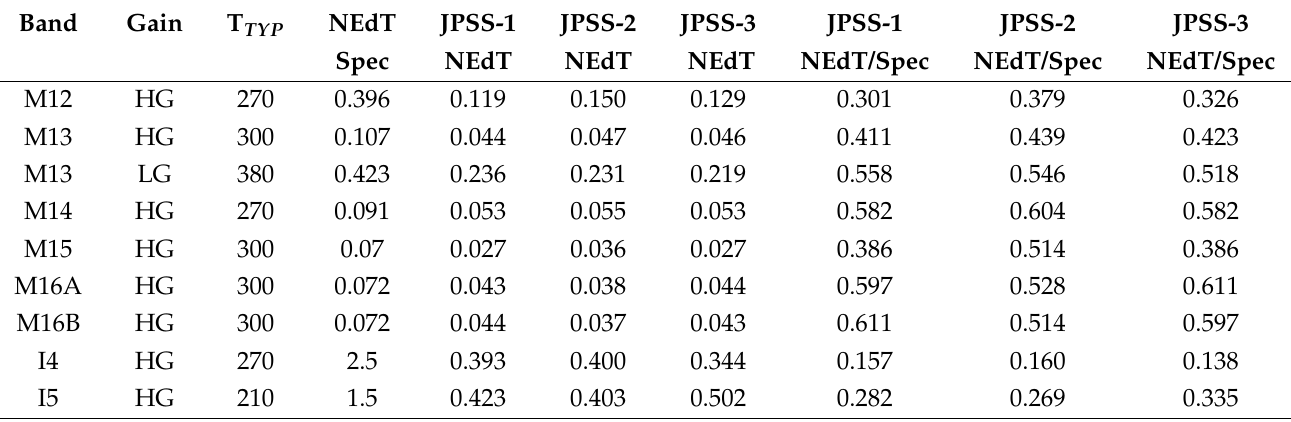
Table 6. JPSS-3 VIIRS TEB NEdT at T TYP relative to the sensor specification [10]. JPSS-1 and JPSS-2 results are included for